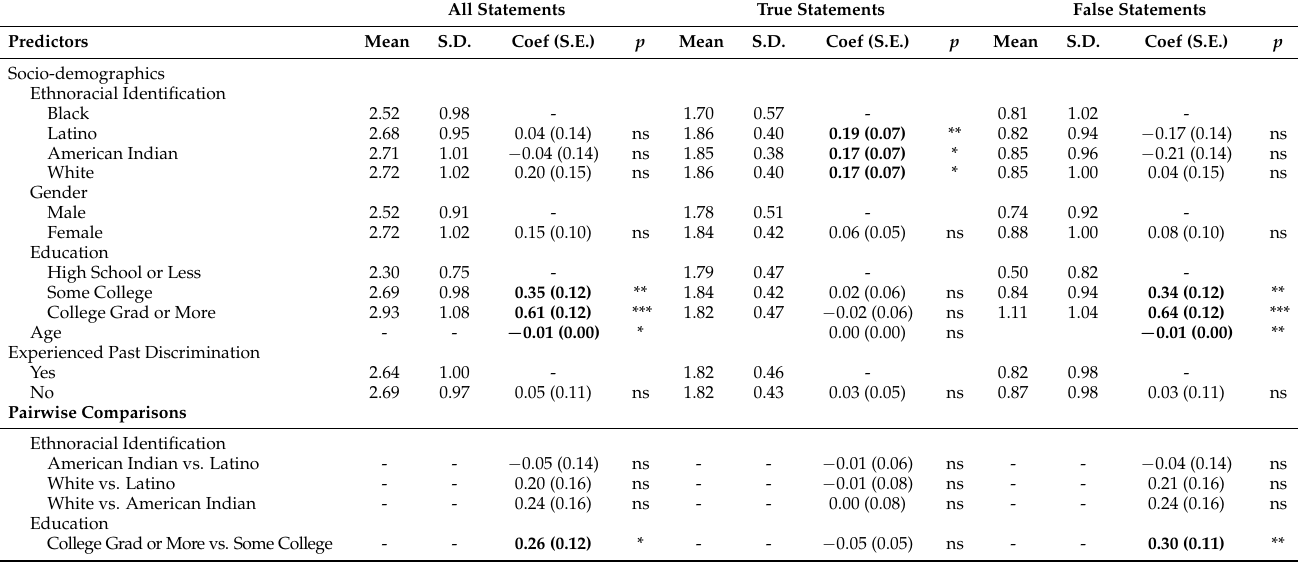
Table 6. Multivariable OLS Regression Models of MRL Scores (Correct Answers) on the Predictor Variables by All Statements, True Statements Only, and False Statements